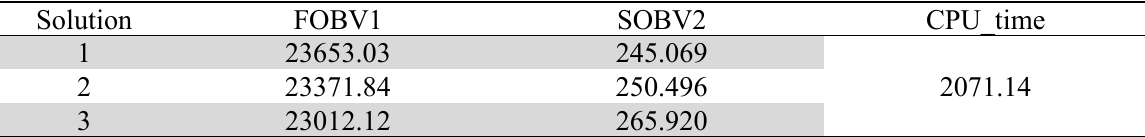
Efficient solutions obtained from solving a small size sample using a comprehensive